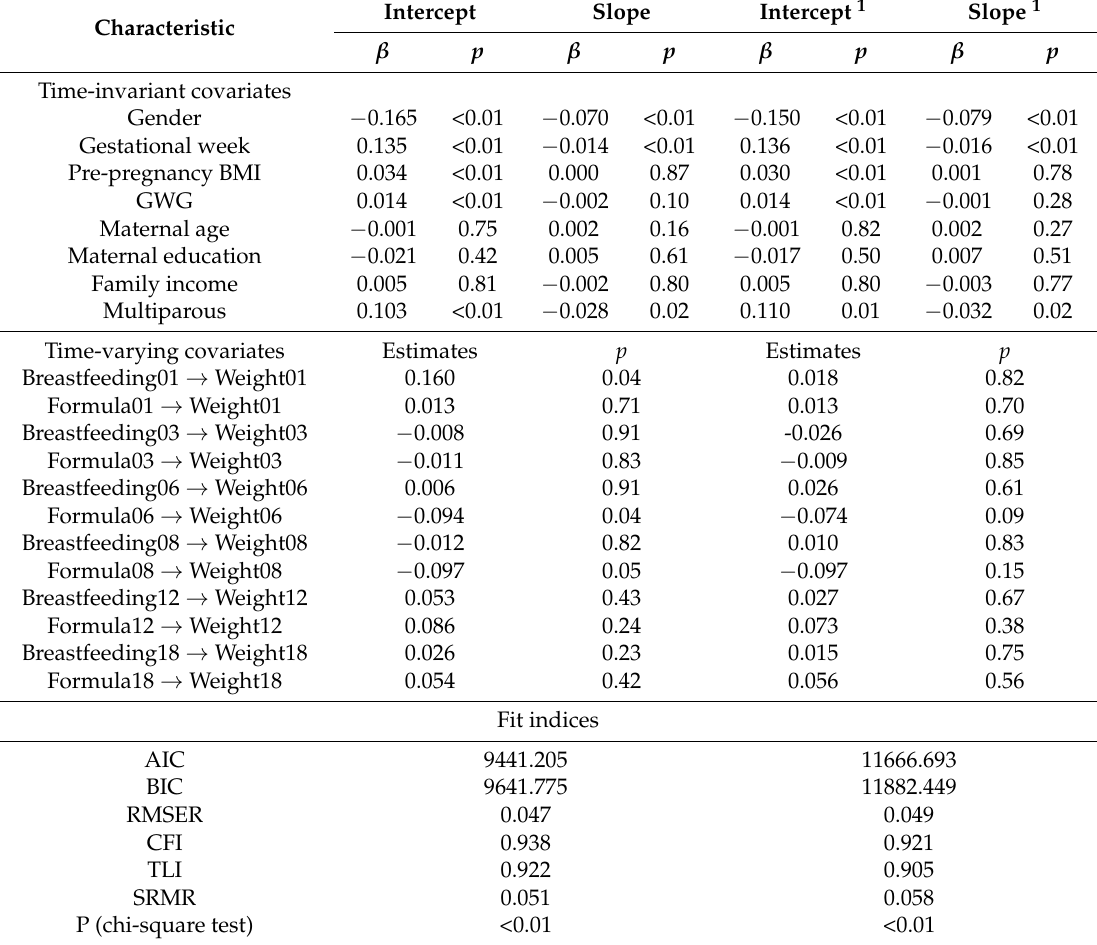
Table 4. Estimates of the intercept and slope of the trajectory of child weight for the